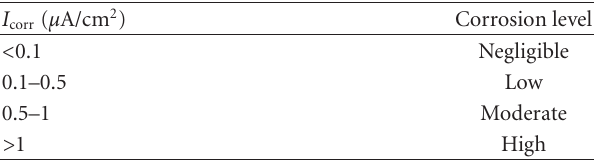
Table 2: I corr in terms of corrosion level.